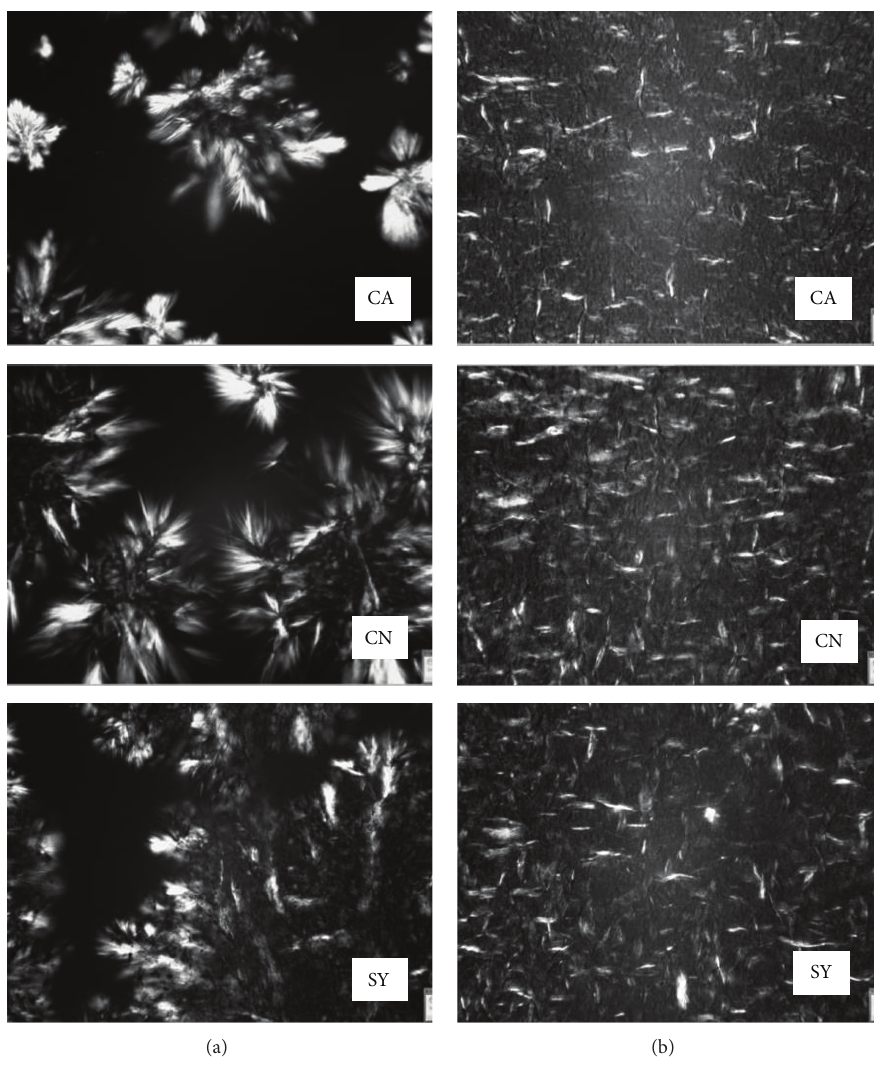
Figure 4: Gels prepared with canola (CA), corn (CN), and soy (SY) oils at concentration 9%, 7200 rpm, and 80 ∘ C of gelators Myvatex (a) and Myverol